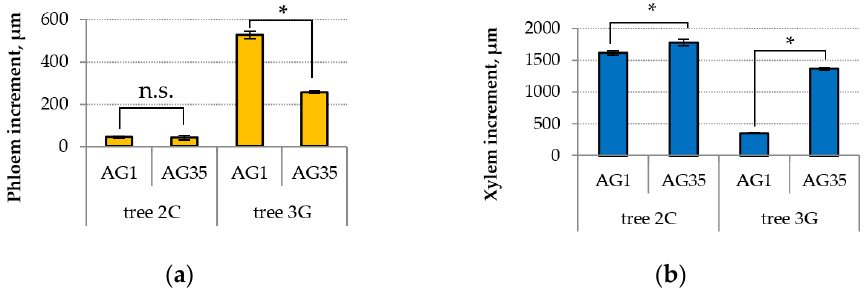
Figure 3. Width of phloem increment ( a ) and xylem increment ( b ), formed after the girdling. Representative values are given for one control (tree 2C) and one girdled tree (tree 3G). Characteristics for all trees can be found in the Supplementary Materials, Figure S1. The data in the diagrams are presented as M ± SD. Asterisks mark significant differences between groups (* p < 0.05), n.s.—no differences.